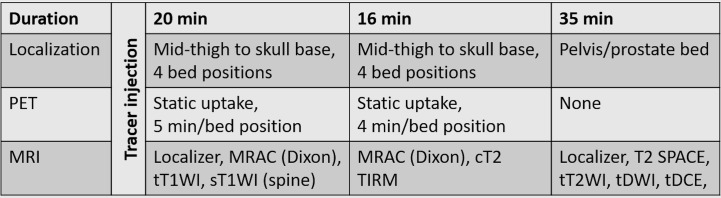
Schematic overview of the PET/MRI protocol. t, transverse plane; c, coronal plane; s, sagittal plane; T2WI, T2-weighted imaging; DWI, diffusion-weighted imaging; MRAC, MR for attenuation correction; T1W, T1-weighted imaging; T2 TIRM, T2-weighted turbo inversion recovery magnitud; T2 SPACE, T2-weighted 3D turbo spin echo; DCE-MRI, dynamic contrast enhanced MRI.